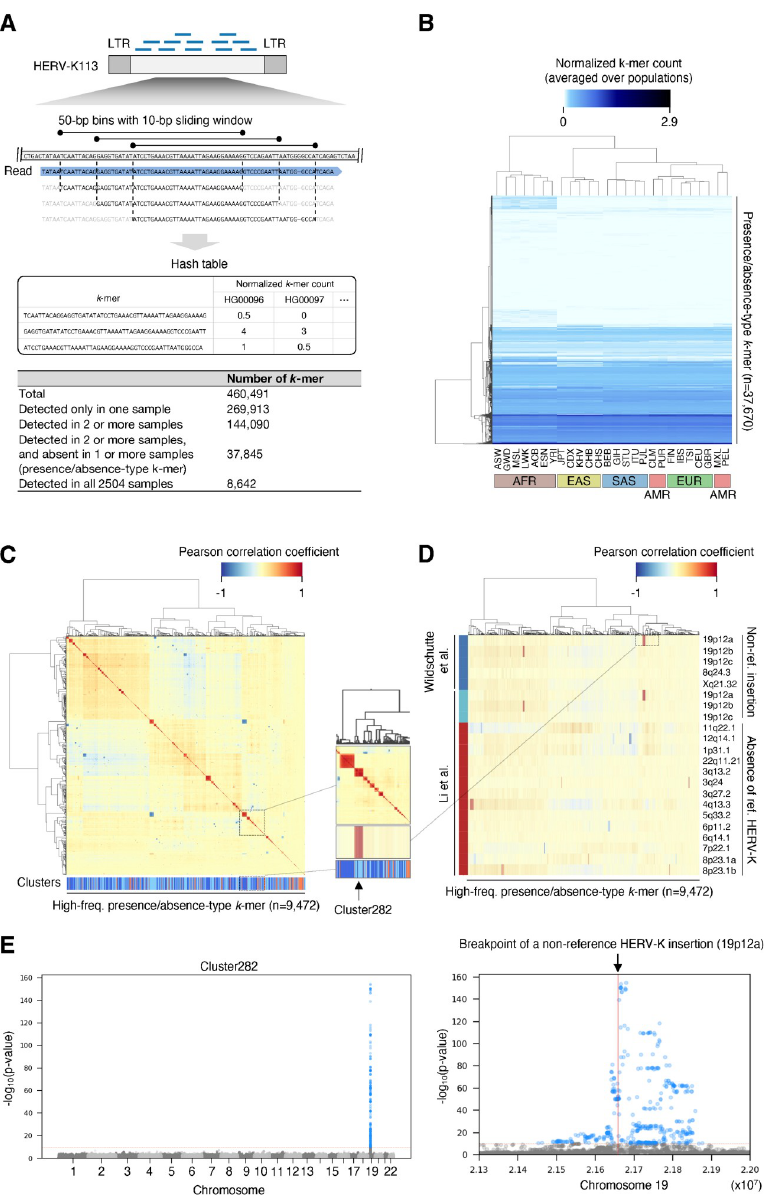
Fig 4. HERV-K k -mer detection from 1,000 Genomes Project WGS. A. Schematic representation of k -mer counting from WGS reads mapping to HERV-K113. The HERV-K113 genome was split into 50-bp bins with a 10-bp sliding window, then, sequences of the mapped reads corresponding to the HERV-K 50-bp bins were listed. The lower table shows the number of k -mers detected from 2,504 WGS datasets from the 1,000 Genomes Project. B. Hierarchical clustering of k -mers based on their frequencies in 26 populations. Heatmap shows the normalized k -mer count averaged over populations. K -mers arising from position 8401 to 8500 were excluded from this analysis to remove any potential k -mers arising from SVA retrotransposons. C. Clustering of presence-absence type k -mers by Pearson correlation coefficient. Clustering were performed by Ward’s method (upper heatmap) and DBSCAN (lower color- bar). The heatmap shows the Pearson correlation coefficient between k -mers, and the lower color-bar shows the clusters. Neighboring k -mer clusters are shown as either dark or light blue. Orange represents the k -mers which were not clustered. D. Correlation between the occurrence of HERV-K k -mers and previously reported HERV-K polymorphisms. Heatmap shows the Pearson correlation coefficient between the presence of k -mers and polymorphic HERV-K reported in the two previous studies. (C, D) Insets in the panel C and D shows that the occurrence of k -mers in cluster282 have high correlation to the presence of known polymorphic HERV-K in 19p12a. E. GWA using occurrence of k -mers detects known polymorphic HERV-K. Manhattan plots show SNVs with association to the occurrence of k -mers in the cluster282. SNVs with p-value lower than 8.33e-11 are shown as blue dots. Red solid line in the right panel shows the position of known non-reference